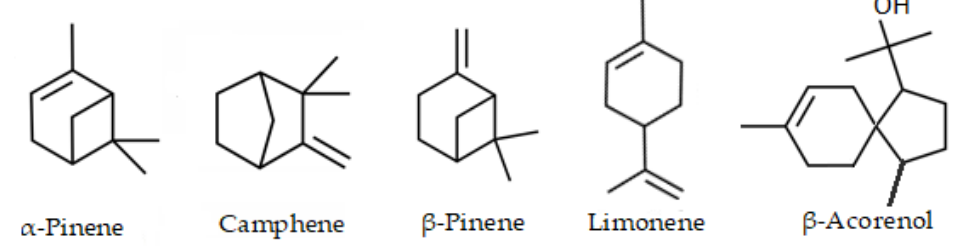
Figure 2. Chemical structures of main compounds of the essential oil from leaves in fruits of Siparuna muricata .